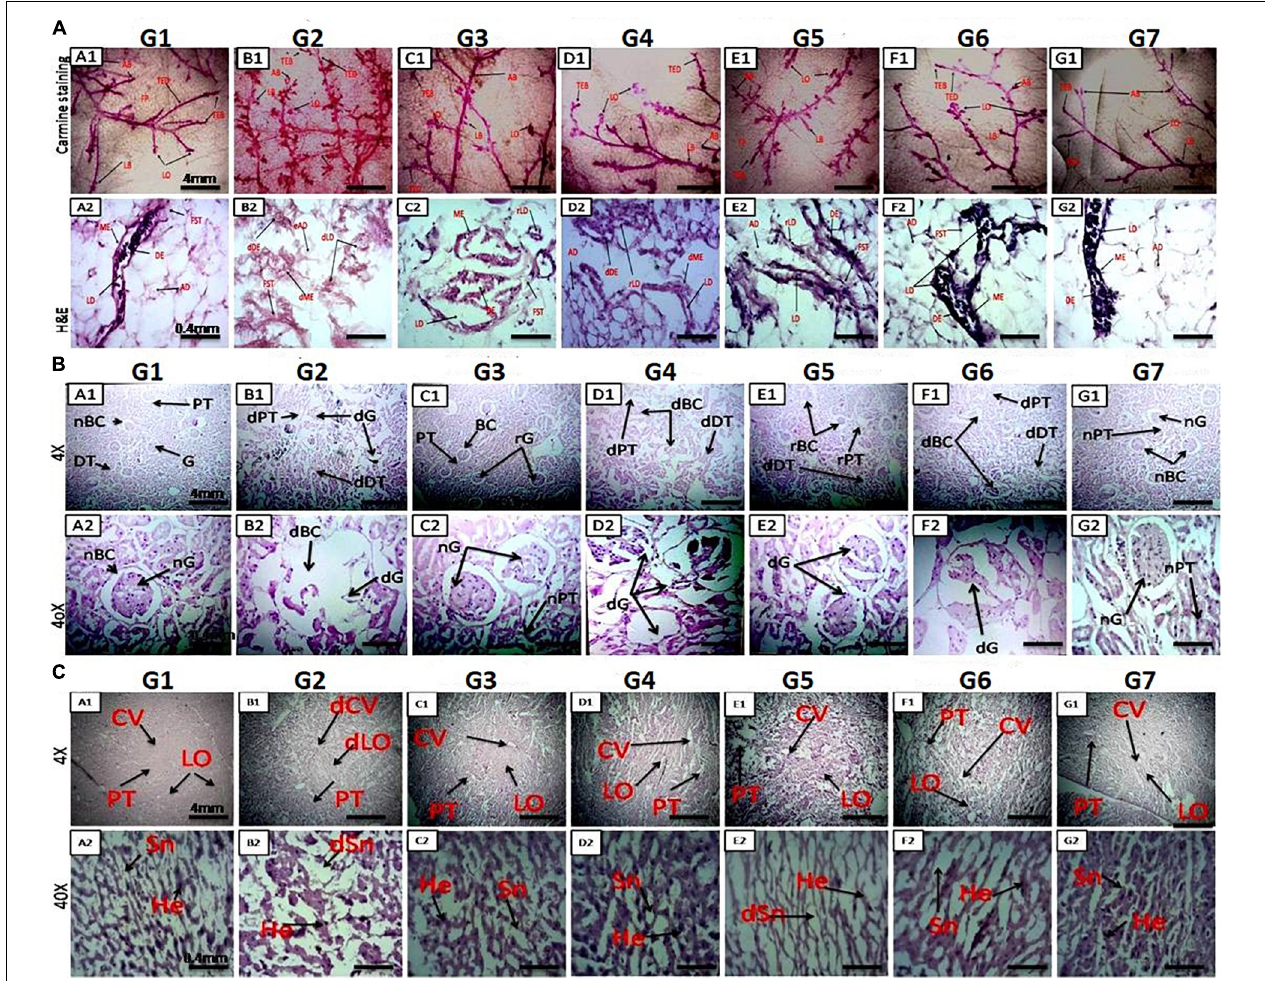
FIGURE 2 | (A) Microscopic examination of rat mammary gland tissue through carmine staining (A1-NC) and H&E staining (A2–G2). A1 and NC show that carmine staining of the mammary gland tissue of NC- and DMSO-treated groups had fewer alveolar buds (ABs), lobules (LOs), lateral buds (LB), and terminal end ducts (TEDs). (B1) DMBA-treated G2 group showing extensive branching of TED, high numbers of AB and LB, and large numbers of LO. (C1–F1) Mammary gland of rats treated with monotherapy and combination therapy of VOA (1 mg/kg) and VIN (1 mg/kg), showing fewer AB counts, LB, TED, and LO when compared to G2. (A2,G2) H&E staining of the mammary gland tissue of the NC group showing typical architecture of the lactiferous duct (LD), adipose tissue (AT), myoepithelial tissue (ME), ductal epithelium (DE), and fibrous stromal tissue (FST). (B2) H&E staining of the mammary gland tissue of the DMBA-treated group showing distorted architecture of the lactiferous duct (dLD), damaged myoepithelium (DME), and damaged ductal epithelium (dDE). (C2–F2) Treatment with monotherapy and combination therapy of VOA (1 mg/kg) and VIN (1 mg/kg) significantly protected against further damage to the mammary tissue, as evidenced by the restoration of regular architecture of LD, AT, and DC ME. (B) Effect of VOA and VIN therapy on rat kidney. (A–G) Kidney sections of rats treated with VOA and VIN at × 4 and × 40 magnification. (A) Kidney of normal rats showing standard architecture of BC, G, PCT, and DCT. (B) G2 rat kidney showing DBC, dG, and distorted architecture of PCT and DCT. (C) VOA-treated rat kidney showing typical architecture of BC, G, PCT, and DCT. (D) VIN-treated rat kidney showing extensive damage to BC, G, PCT, and DCT. (E, F) Kidney of rats treated with combination therapy of VOA and VIN showing even more damage to BC, G, and microtubules (PCT and DCT). (G) Kidney of rats treated with 3% DMSO showing standard architecture of the kidney. dBC, damaged Bowman’s capsule; dG, damaged glomerulus; PCT, proximal convoluted tubule; DCT, distal convoluted tubule. (C) Effect of VOA and VIN therapy on rat liver. A1-NC and A2–G2: Histology of rats treated with VOA and VIN at × 4 and × 40. (A1,A2) Liver sections of NC rats showing typical architecture of liver lobules (LO), hepatocytes (He), sinusoids (Sn), and central vein (CV). (B1,B2) Liver section of G2 rats showing dilated central vein, damaged He, and distorted Sn and Lo. (C1,C2) Liver sections of VOA-treated rats showing slight dilation of CV, intact lobular structure, no distortion of Sn, and regular He. (D1,D2) Liver section of VIN-treated rats showing dilated CV, distended portal triads (PT), and enhanced sinusoidal space. (E1,E2,F1,F2) Liver sections of rats treated with low- and high-dose combination therapy of VOA and VIN showing extensive distortion of Sn, damage to He, enlargement of central and portal triads, and disruption of lobular structure. (NC-G2) Liver section of rats treated with 3% DMSO showing standard liver architecture similar to